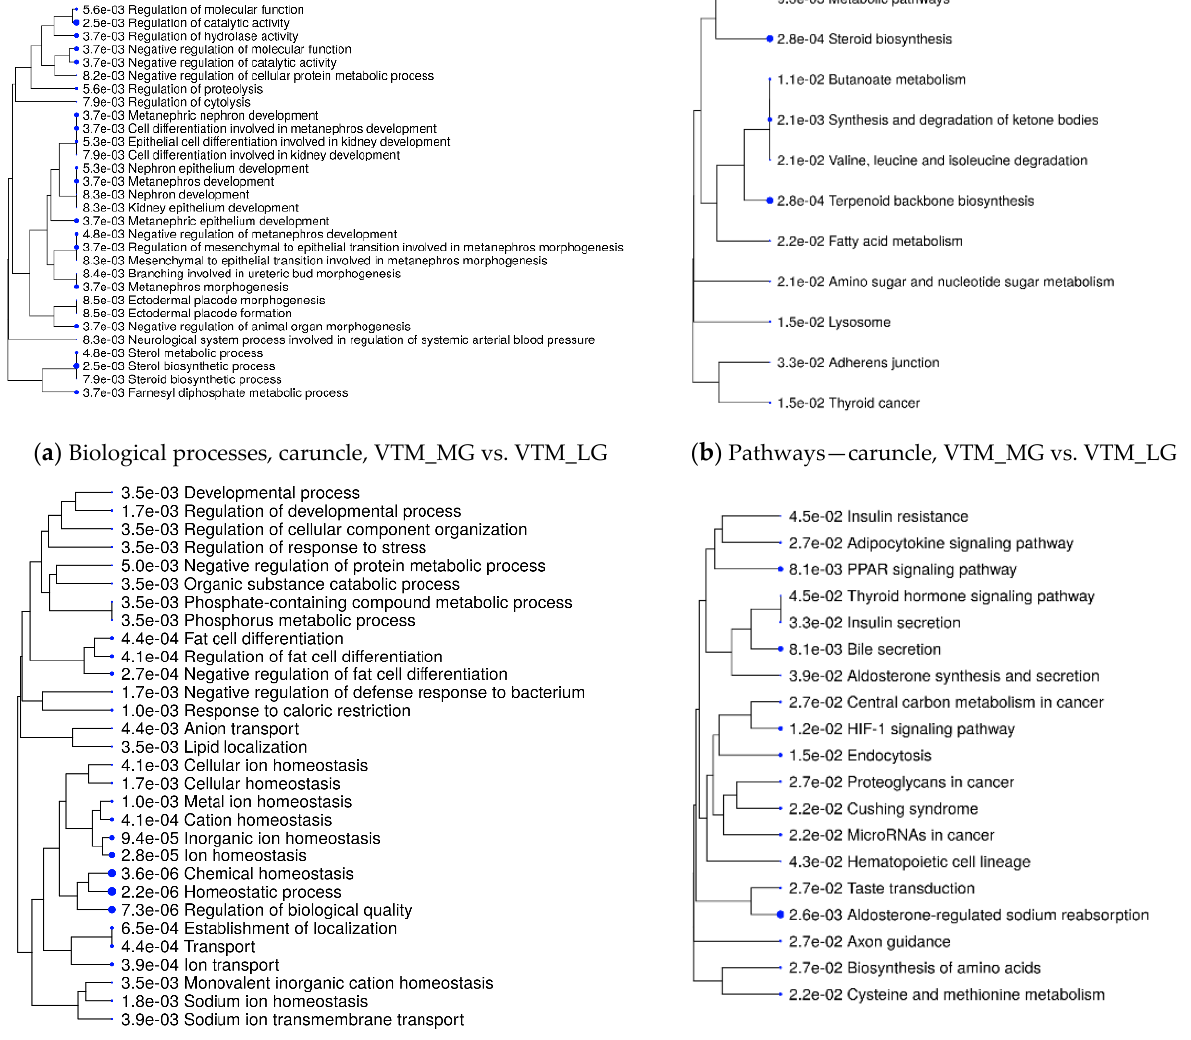
Figure 3. Functional over-representation analysis of differentially expressed genes (DEGs) from bovine placental tissues— caruncle (maternal placenta) and cotyledon (fetal placenta). Biological processes and KEGG pathways over-represented from DEGs in the caruncle ( a , b ) and cotyledon ( c , d ). The terms are hierarchically arranged based on functional similarity. The bigger the blue dot, the more significant the term is (FDR < 0.05).